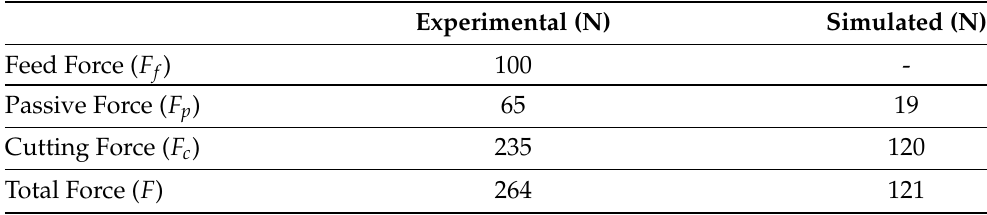
Figure 7. Simulated chip profile by 2D machining model. Table 4. Comparison of forces predicted by 2D model with experiments.